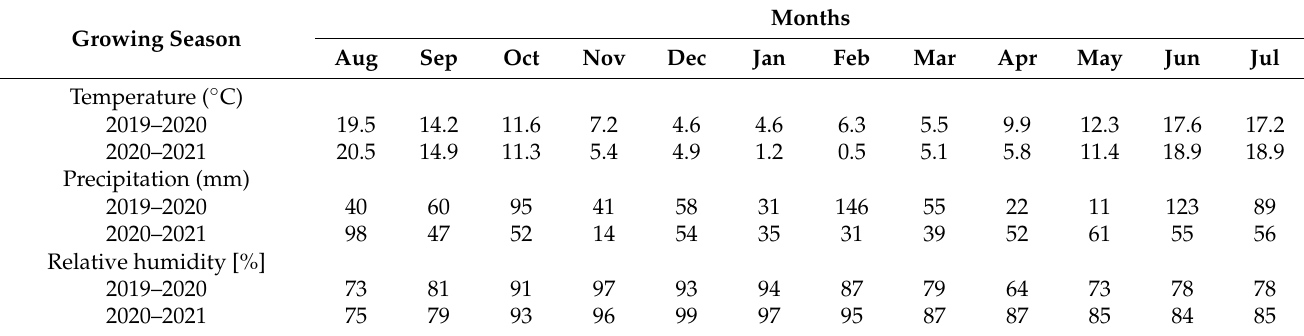
Table 3. Monthly mean air temperature ( ◦ C), precipitation (mm), and relative humidity (%) during two consecutive growing seasons (2019–2020 and 2020–2021) of winter oilseed rape in Salzdahlum, Lower Saxony, Germany (German Weather Service (DWD); Salzdahlum,